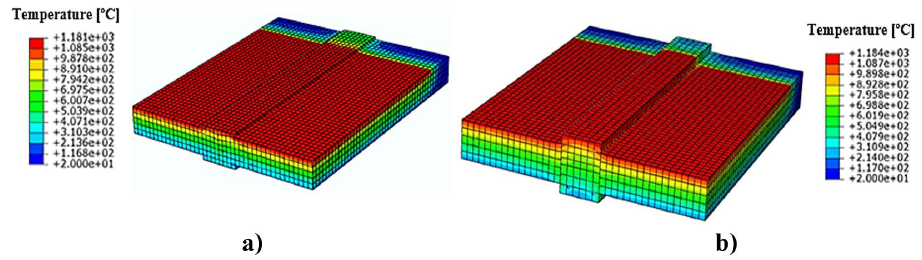
Figure 10. Columns thermal field: a) H220-CONC-ORT-T15 e b)